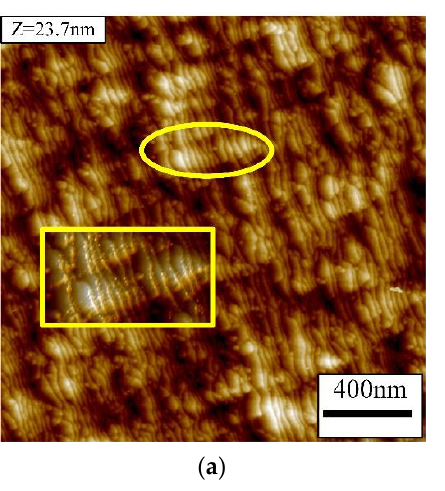
Figure 9. The surface morphology of the sample near the target area. ( a ) Island-like structures of the surface; ( b ) Sectional view of the island-like structures.